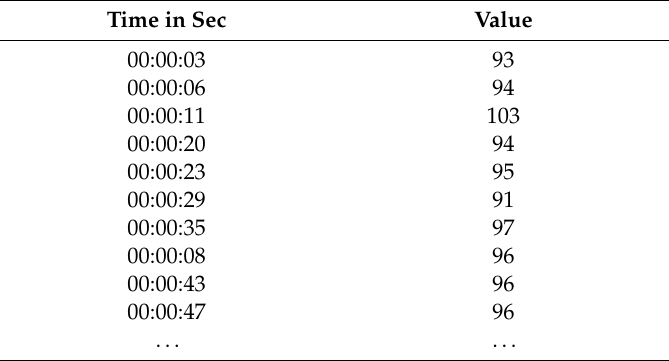
Table 1. Example of Heart rate